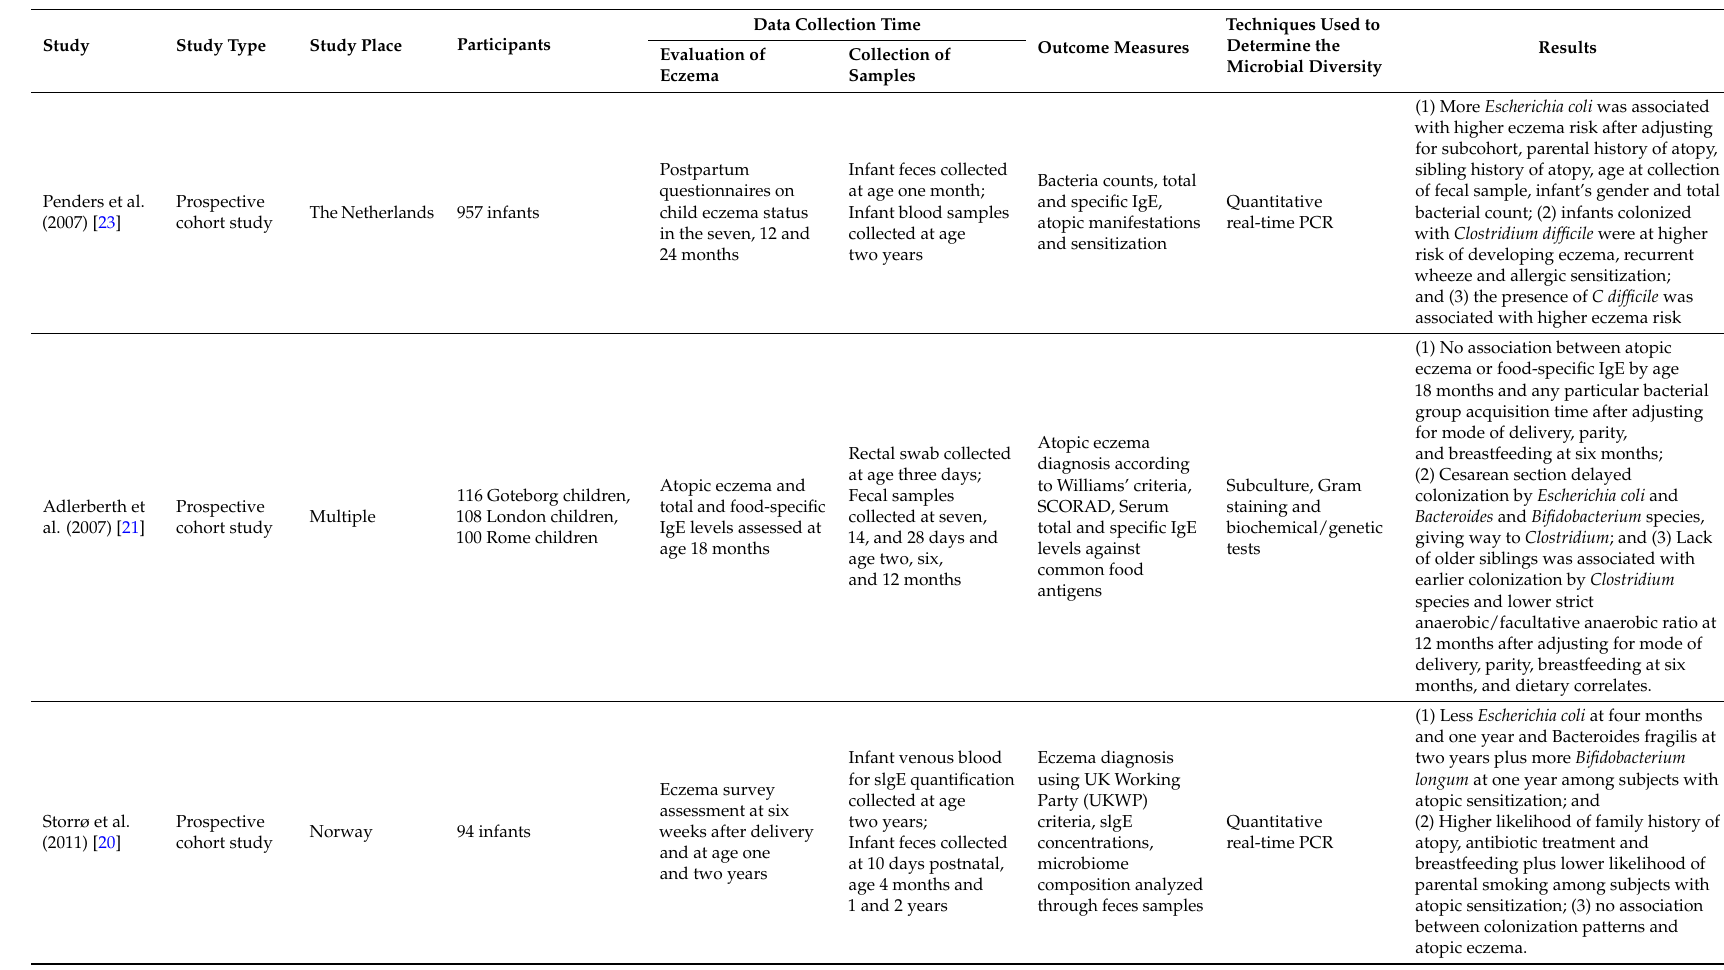
Table 1. Characteristics of original